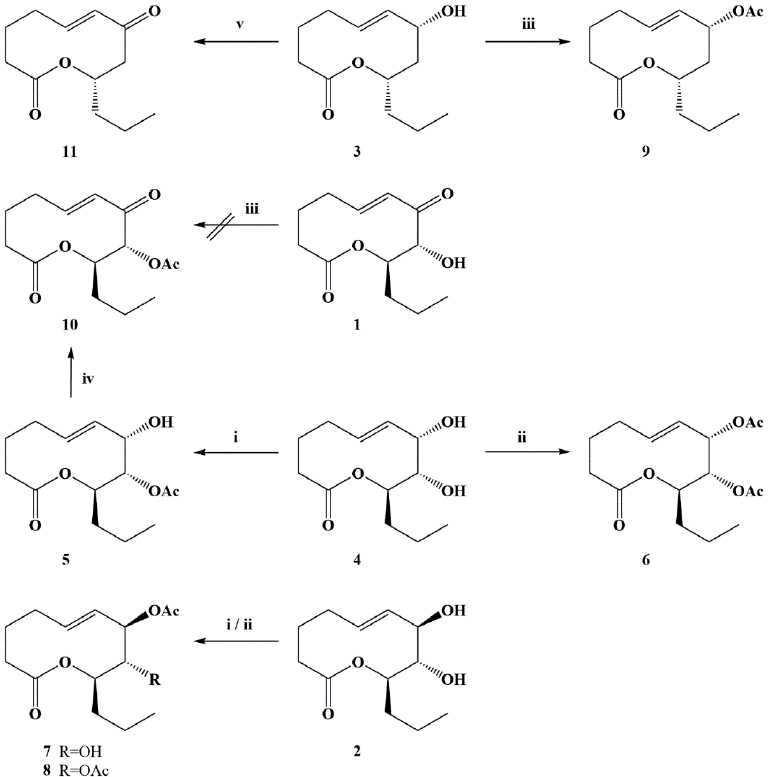
Figure 2. Scheme of modification of natural nonenolides 1—4 . Reagents and conditions: (i) 2 eq Ac 2 O, Py, r.t.; (ii) 60 eq Ac 2 O, Py, r.t.; (iii) 20 eq Ac 2 O, Py, r.t.; (iv) 20 eq MnO 2 , CH 2 Cl 2 , r.t.; (v) 10 eq BaMnO 4 , CH 2 Cl 2 , r.t.